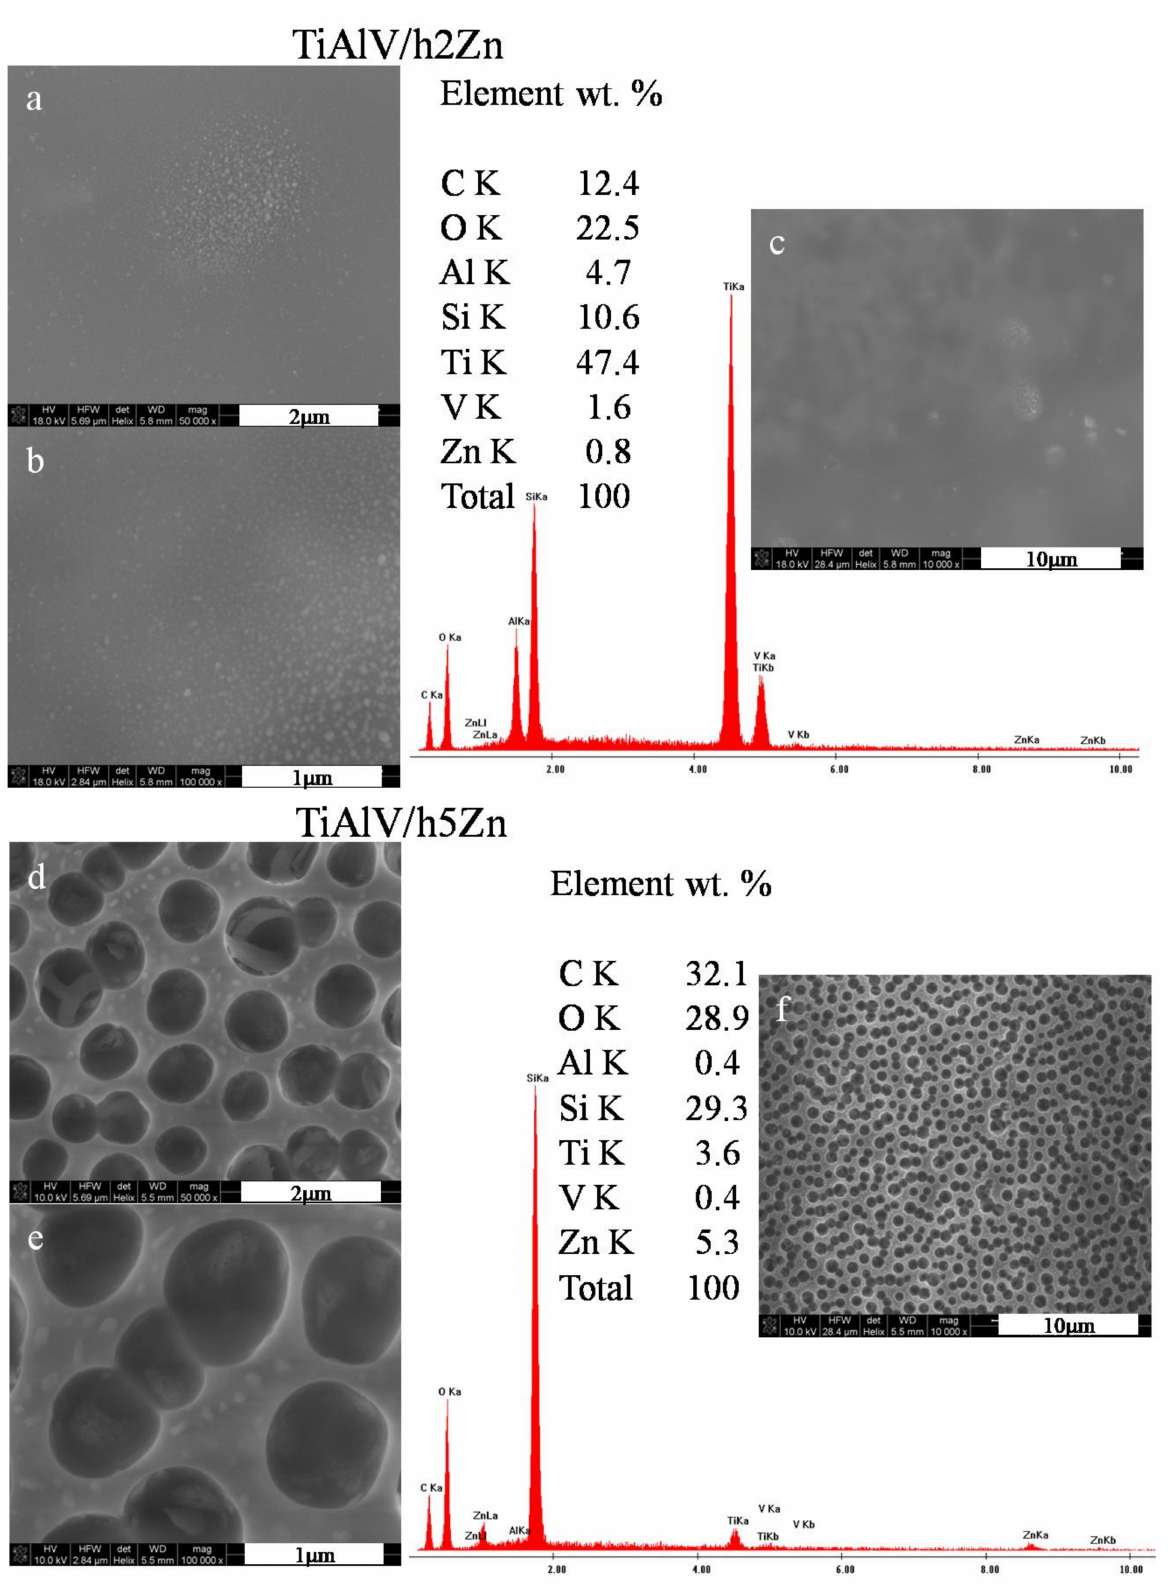
Figure 3. SEM images and EDS spectra of titanium alloy (TiAlV)-covered sol–gel hybrid layer containing zinc nanoparticles; ( a – c ) containing 2% ZnNPs, and ( d – f ) containing 5%